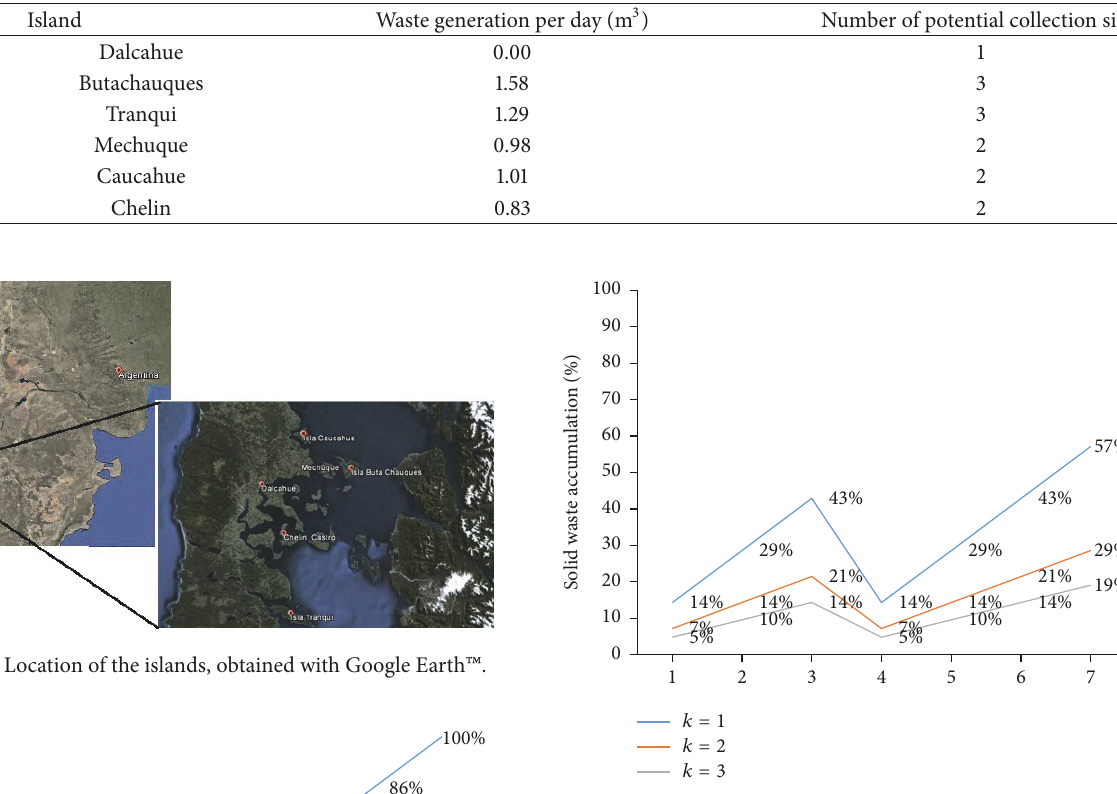
Figure 3: Solid waste accumulation per day 𝑡 for 𝑝 = 7, 8, 9 and 𝑘 = 1, 2,3 .